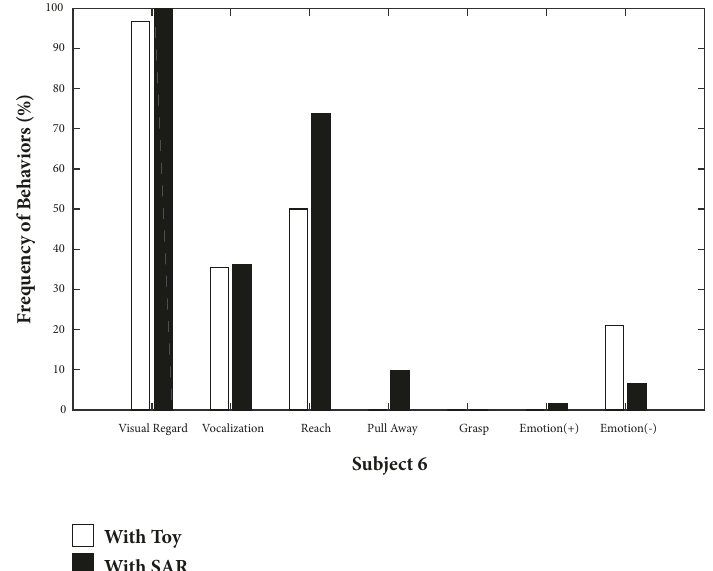
Figure 8: Results for Subject 6, which show a higher level of interaction with the SAR over the switch-adapted toy when considering the primary behaviors as well as Positive and Negative Emotion.